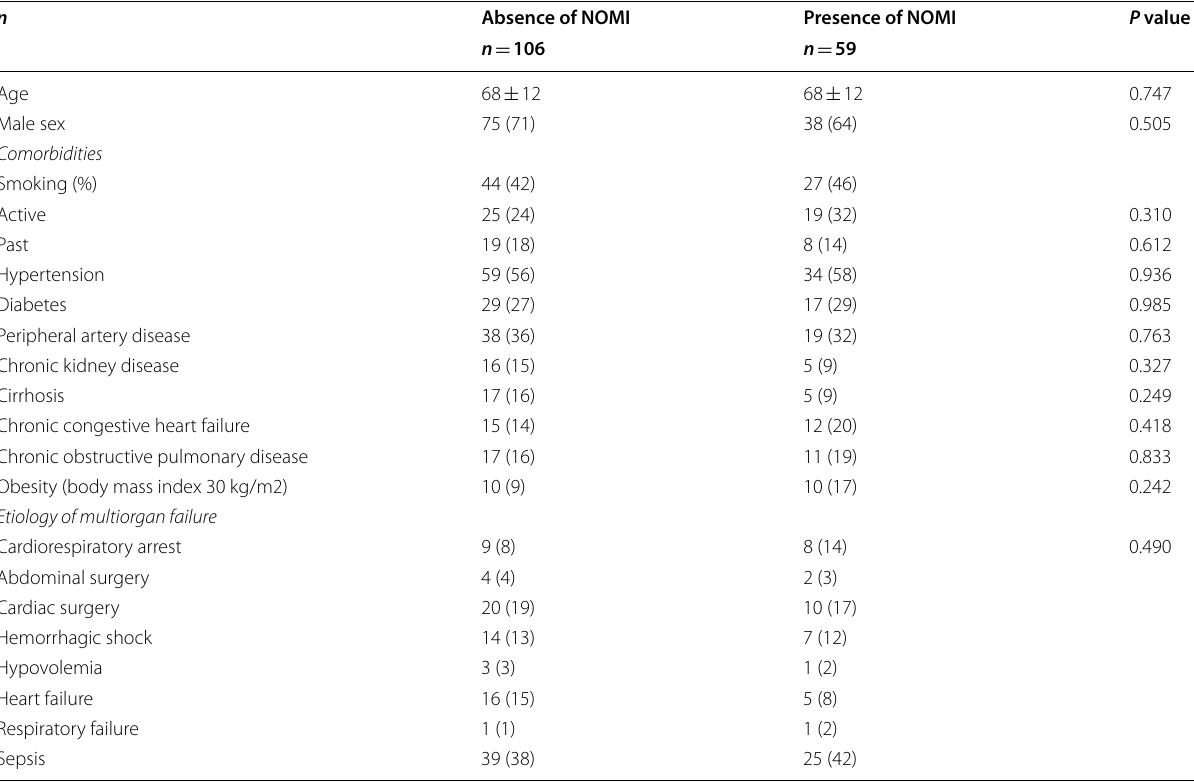
Table 2 Characteristics of the study